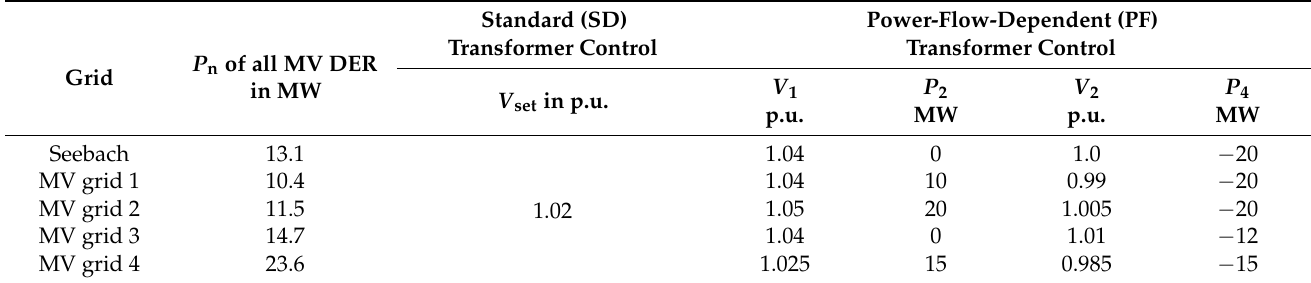
Table 4. Detailed information about the five selected example MV